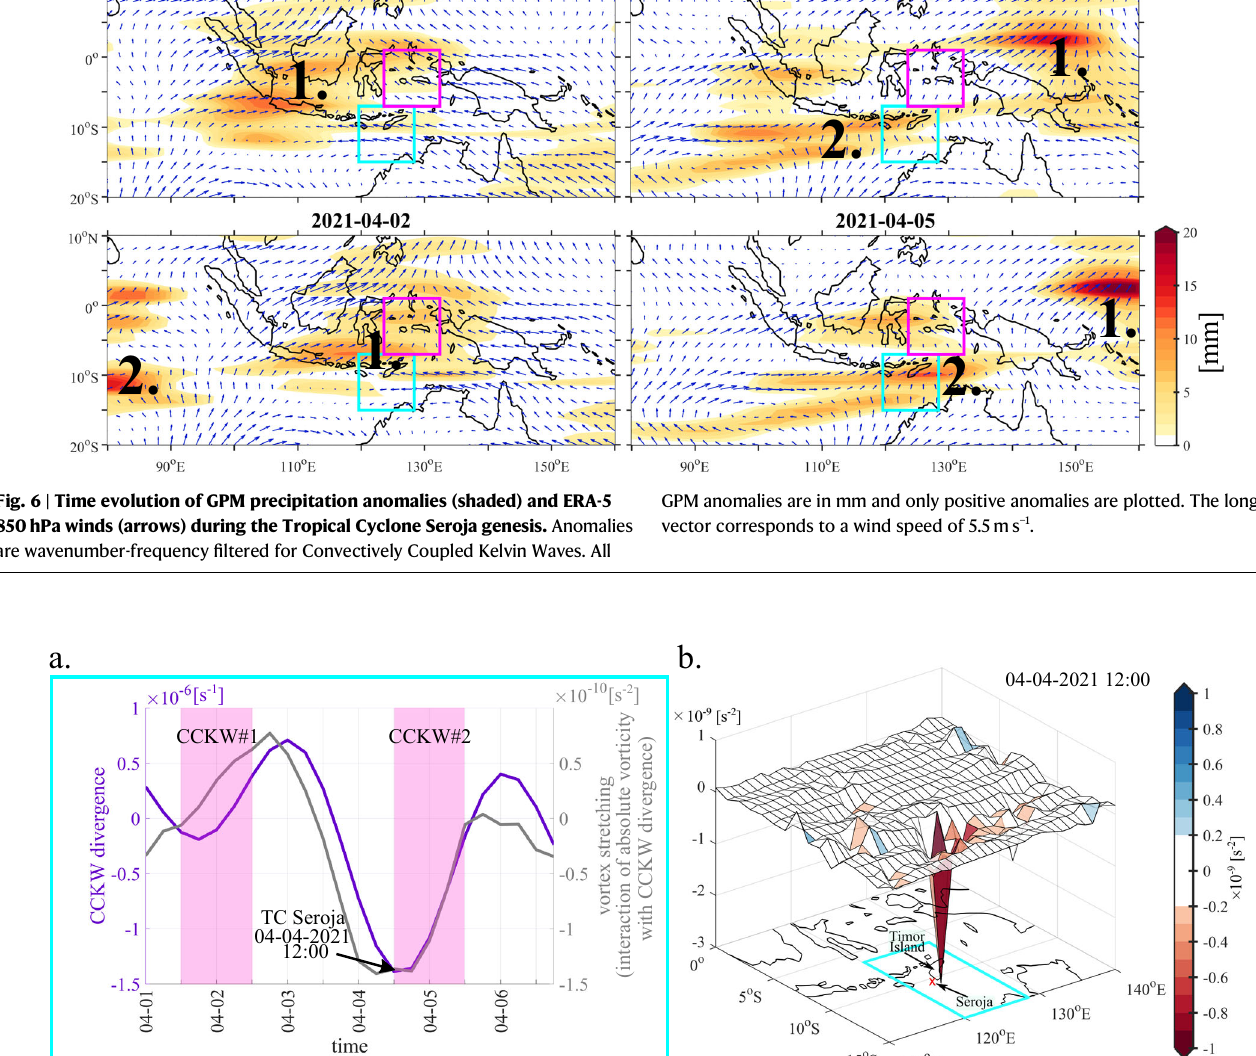
Fig. 7 | Convectively Coupled Kelvin Wave (CCKW) in fl uence on vorticity. a CCKW low-level (850hPa) divergence (left axis) together with vortex stretching: low-level CCKW divergence acting on absolute vorticity (right axis), averaged over Serojabox.Two pinkboxes indicate periodsof two sequentialCCKWoccurrences.